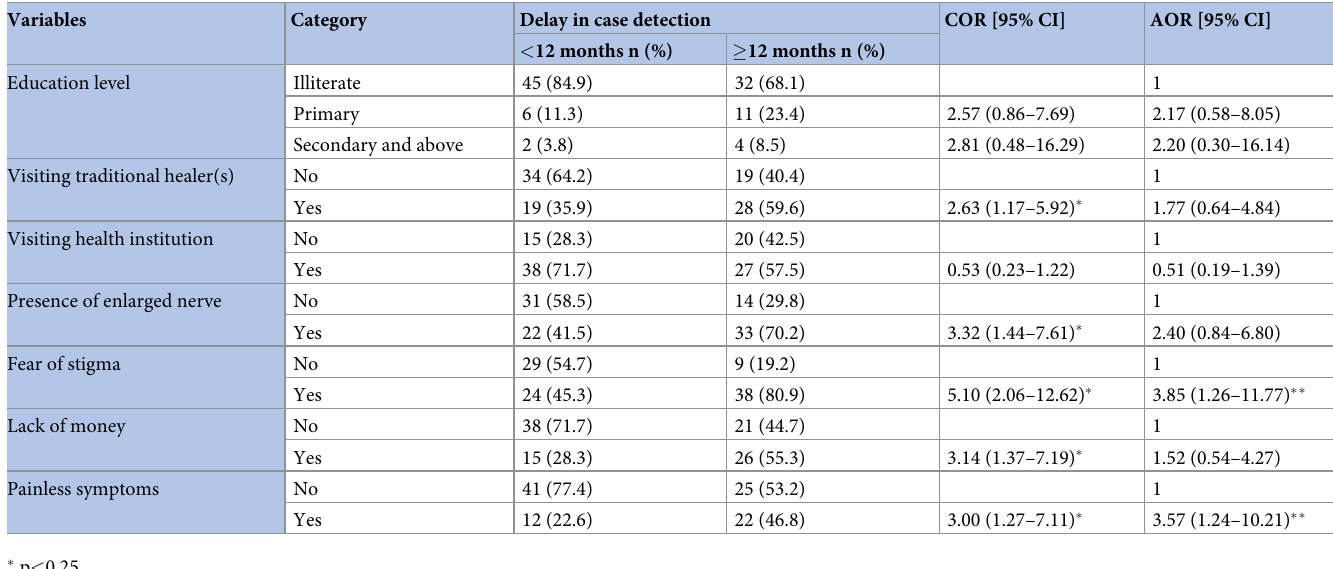
Table 3. Association between delays in case detection and related factors among the 100 study participants, Eastern Ethiopia, January-February 2019.